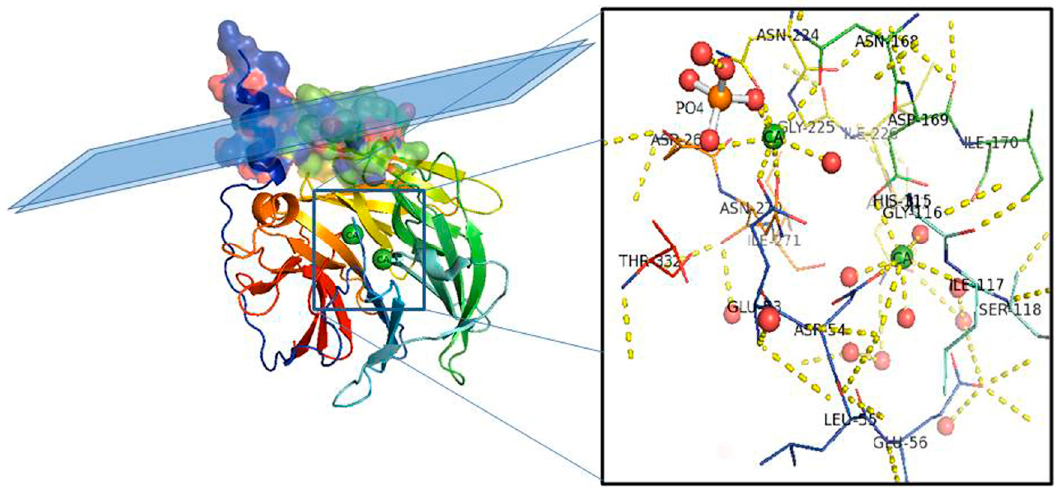
Figure 1. PON1 protein structure. Side view of the six-bladed propeller-like structure of PON1. The top left side of the structure (molecular surface colored by atoms and ribbon view in transparency) shows the retained N-terminal helix A and helix B taking contact with a schematic lipid surface (phospholipids of a high-density lipoprotein (HDL) particle; membrane in the case of PON2). The N and C termini and the two calcium atoms (green balls) localize in the central tunnel of the propeller. The ribbon of PON1 molecule is colored by chain progression. Residues interacting with the two calcium ions and phosphate are shown with line representation (inset) . Red balls are water molecules . Picture was drawn by the Pymol program (The PyMOL Molecular Graphics System, Version 2.0. Schrödinger, LLC.).